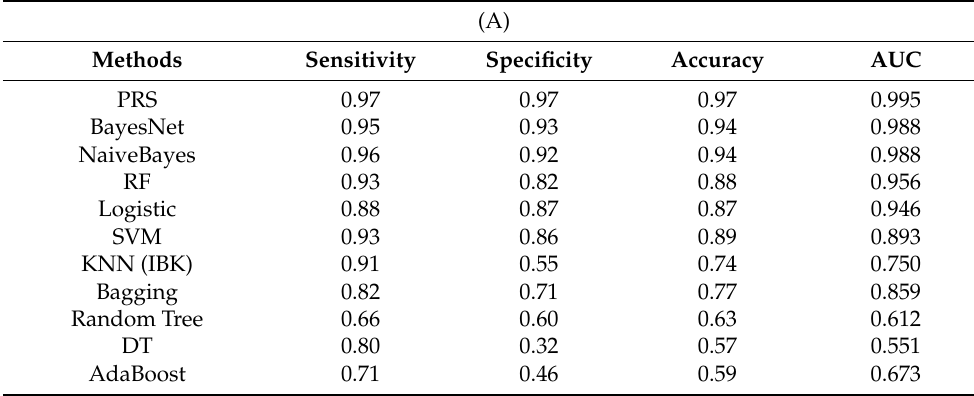
Figure 4. The performance of the platinum–based chemotherapy response genetic model in the discovery cohort. The sensitivity (black curve), specificity (blue curve), accuracy (red curve), and AUCs of ROC curves of the models established using different algorithms were indicated. ( A ) The medium correlation models; ( B ) the high correlation models; ( C ) the prior models; ( D ) AUCs of ROC curves of the models established by PRS. Table 3. (A) The sensitivity, specificity, accuracy, and the AU-ROC of each model established by the SNPs with p < 10 − 3 in the discovery cohort. (B) The sensitivity, specificity, accuracy, and the AU-ROC of each model established by the SNPs with p < 10 − 4 in the discovery cohort. (C) The sensitivity, specificity, accuracy, and the AU-ROC of each model established by the SNPs selected using the candidate gene method in the discovery cohort.